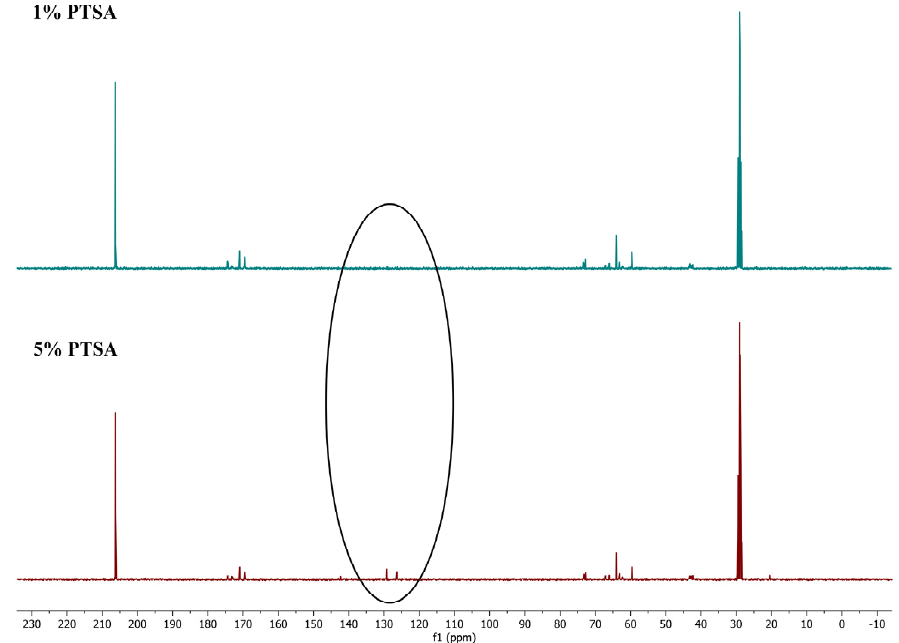
Figure 3. 3 C − NOE NMR spectra of selected poly(1,2-ethanediol) samples with different catalyst con- tent.